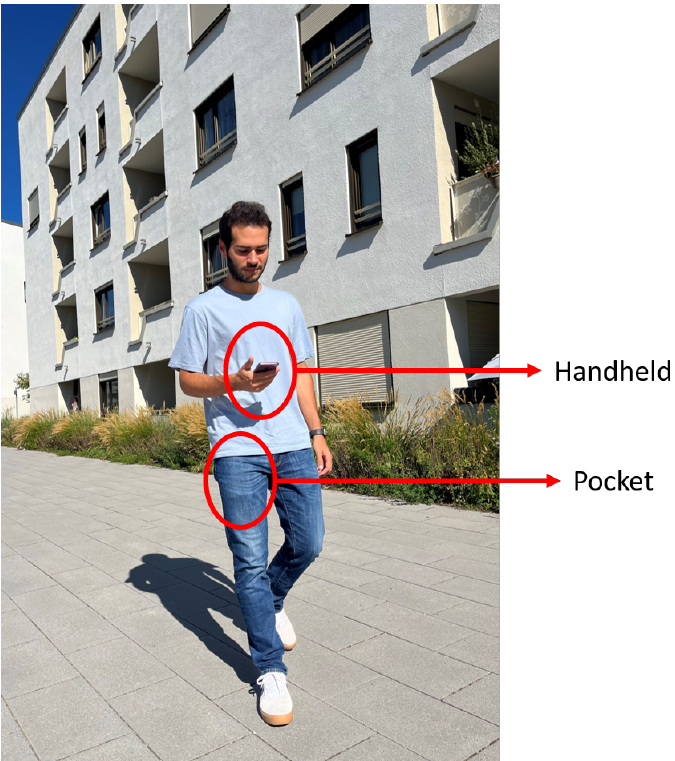
Figure 2. Experimental set-up. The volunteers carry two smartphones in different positions: in the front pocket of the trousers and held in the hand.